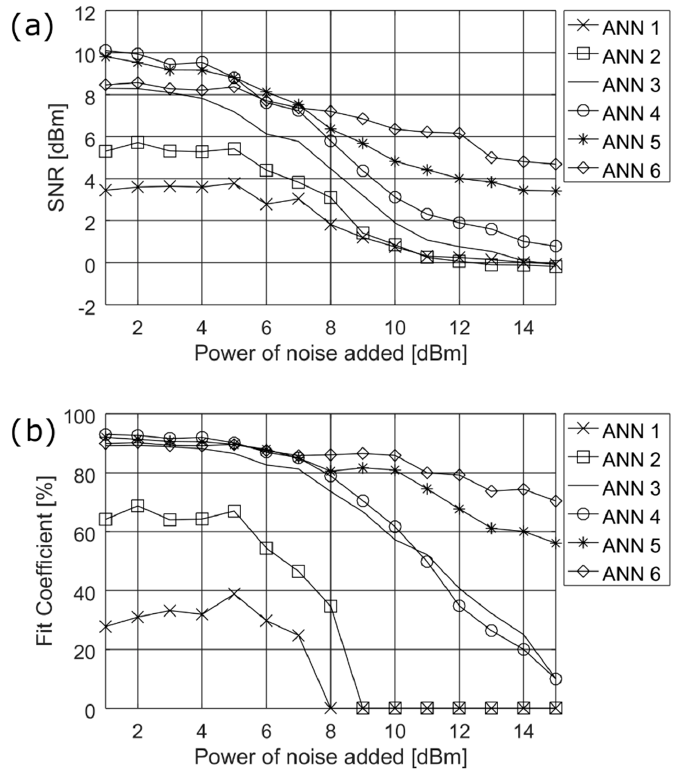
Figure 4. Simulation results for finding the most suitable structure of the NN, ( a ) of SNR and ( b ) of fit coefficient .